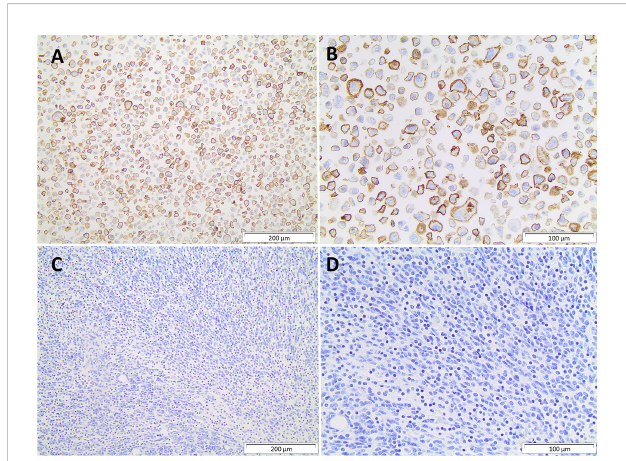
FIGURE 3 Immunohistochemistry PD-L1 protein. (A, B) Strong membrane immunostaining of positive control with 200µm and 400µm magni fi cation, respectively; (C, D) absence of PD-L1 immunostaining in a medulloblastoma, 200µm and 400µm magni fi cation,